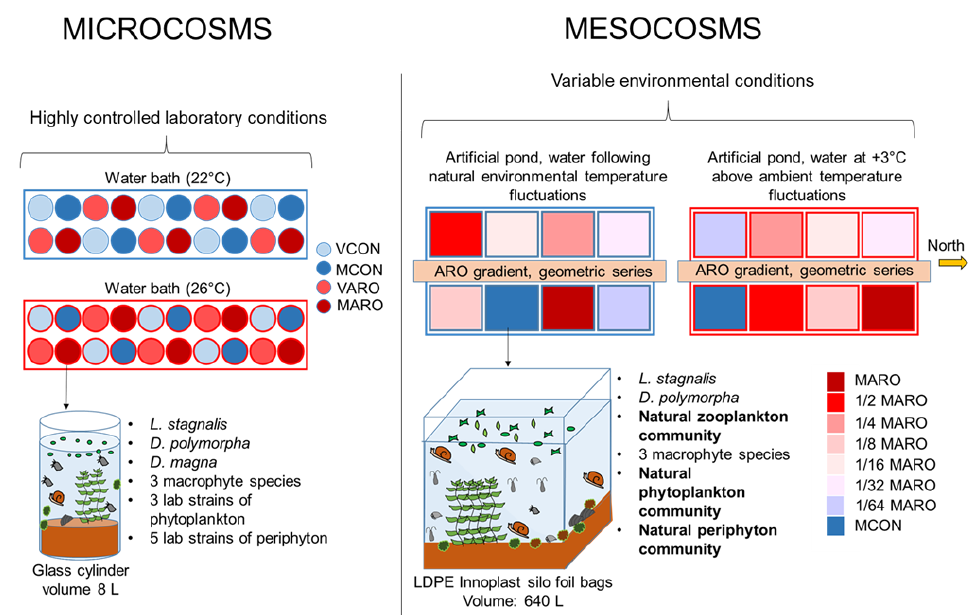
Figure 1. Comparison of the design between the indoor controlled microcosms and the outdoor vari- able mesocosms. The concentrations of the pesticides and nitrate comprising the agricultural runoff (ARO) in the microcosms were comparable to the highest ARO in the mesocosms. VCON = Volvic water control, MCON = Munich water control, VARO = Volvic water ARO and MARO = Munich water